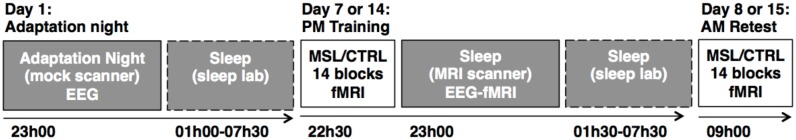
Overview of experimental design.On Day 1, subjects (n = 13, 7 female) first underwent a screening and adaptation night (bed time: 23h00) in the mock scanner under conditions similar to those experienced in both experimental and control nights to ensure that they could attain adequate sleep required for subsequent post-training sleep sessions in the MRI scanner. Subjects returned (Day 7 and Day 14) for training on either the motor sequence learning (MSL) or motor control (CTRL) task, which were administered in a random order in two separate sessions that took place on two consecutive weeks. Practice on either of these two tasks began in the evening around 22h30, and was followed by simultaneous EEG-fMRI sleep recording (starting at 23h00) lasting up to ~2.25 hours. Subjects were then allowed to sleep for the remainder of the night in the sleep lab until 07h30. This was followed by retest sessions on the same task as the previous training session (Day 8 and Day 15) comprising both behavioral and imaging data collection in the morning beginning at 09h00.